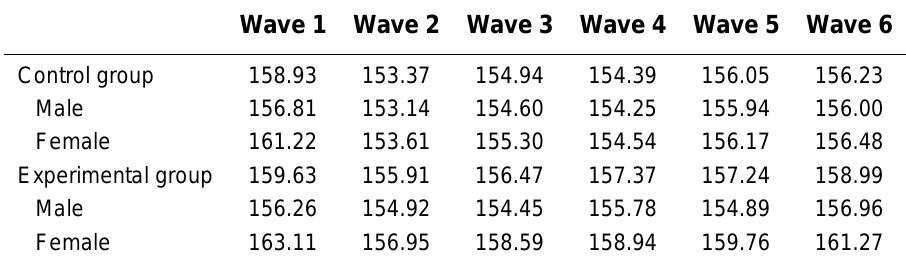
Mean KEY 36 Indicator Scores at Each Measurement